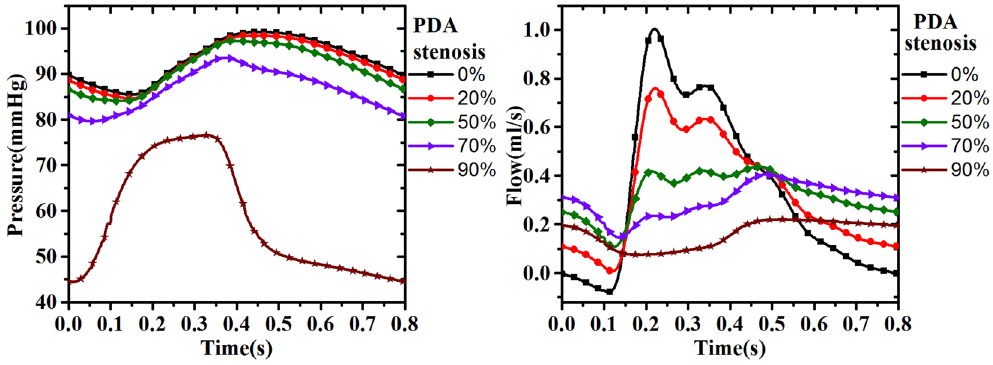
Figure 4. The pressure (left) and flow (right) for different degrees of stenosis in